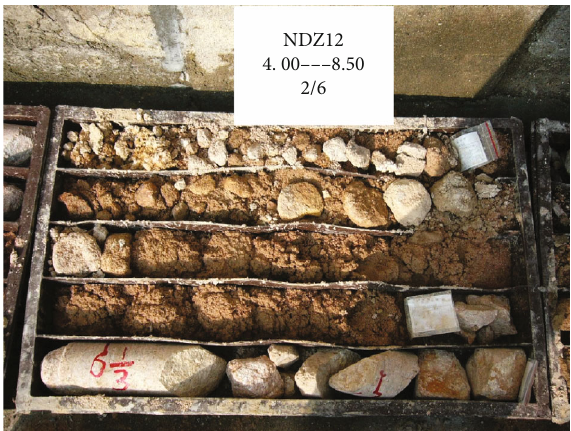
Figure 1: Borehole lithologic